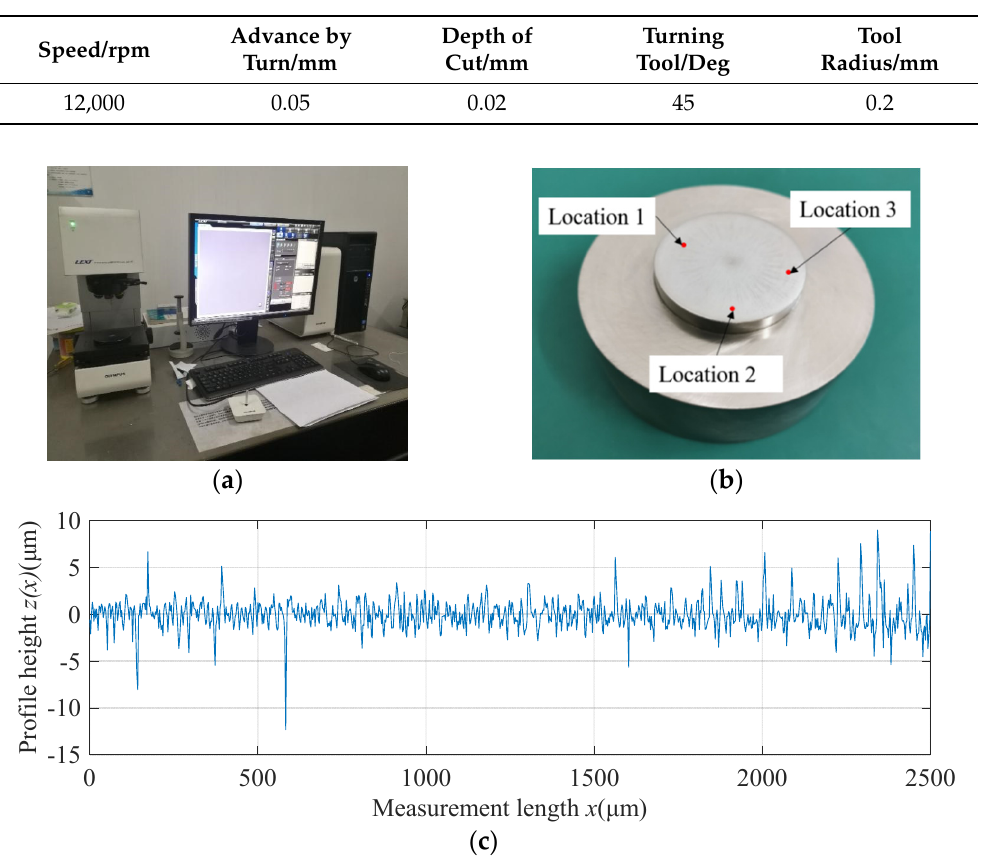
Figure 10. The measurement instrument and the measuring surface topography: ( a ) sealing surface measuring instrument (OLYMPUS OLS4100); ( b ) test specimen and measuring locations; ( c ) original profile of the sealing